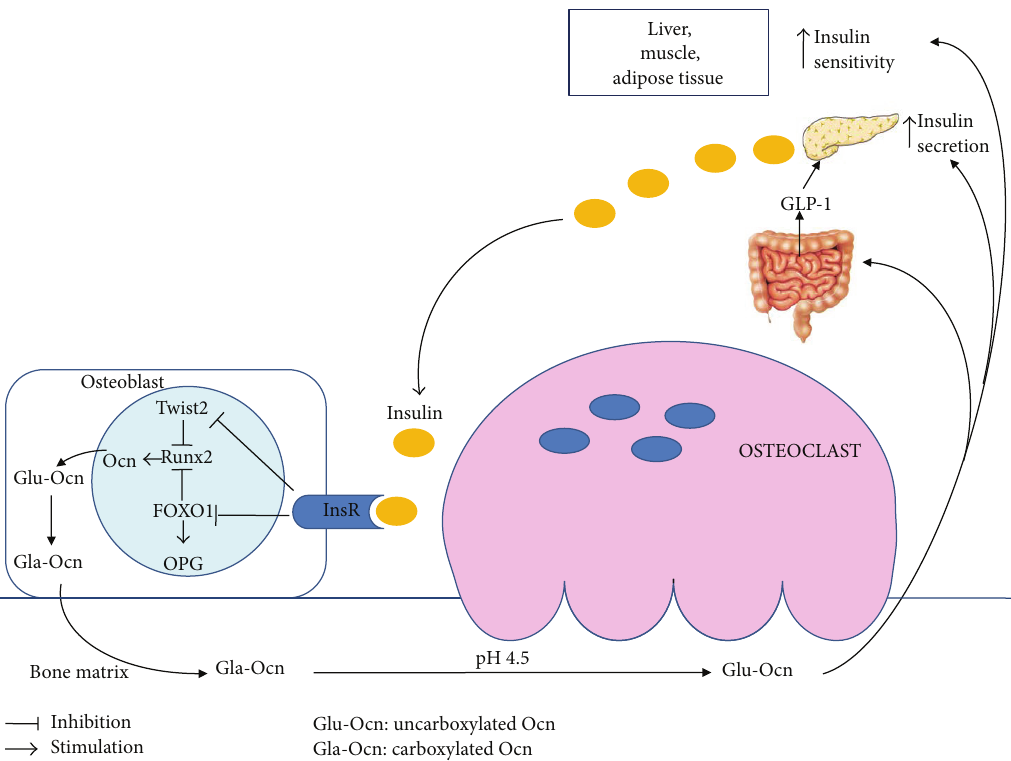
Figure 1: Interplay between Ocn and insulin